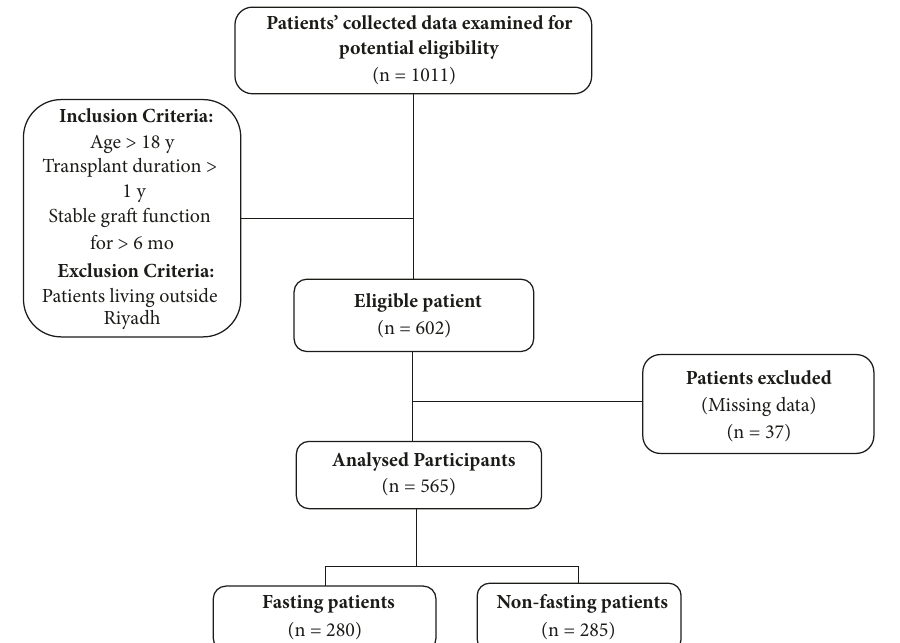
Figure 1: Flow chart illustrates subject enrollment and analysis. A total of 565 subjects were included for analysis in this retrospective cohort